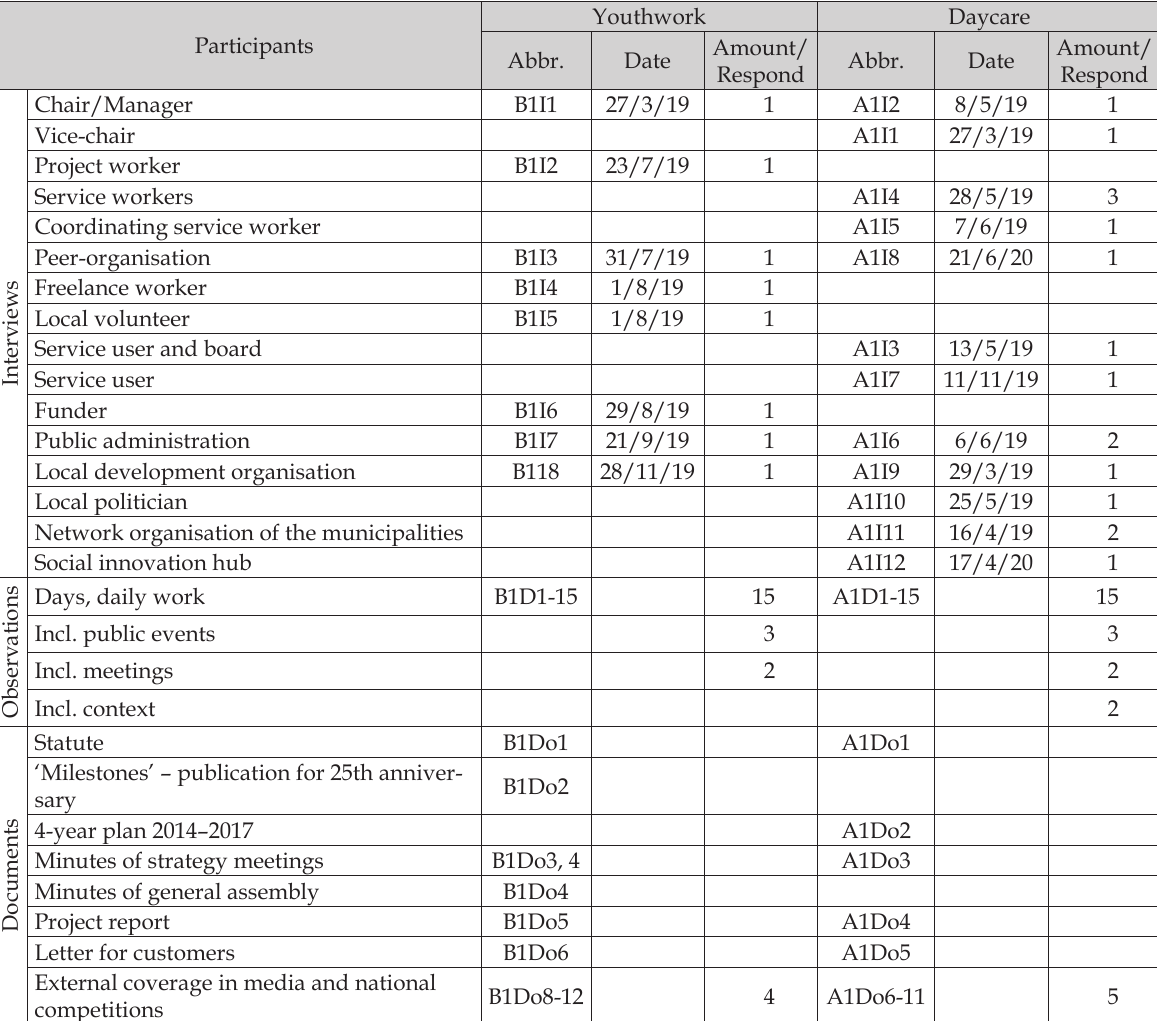
Table 1. The amount of